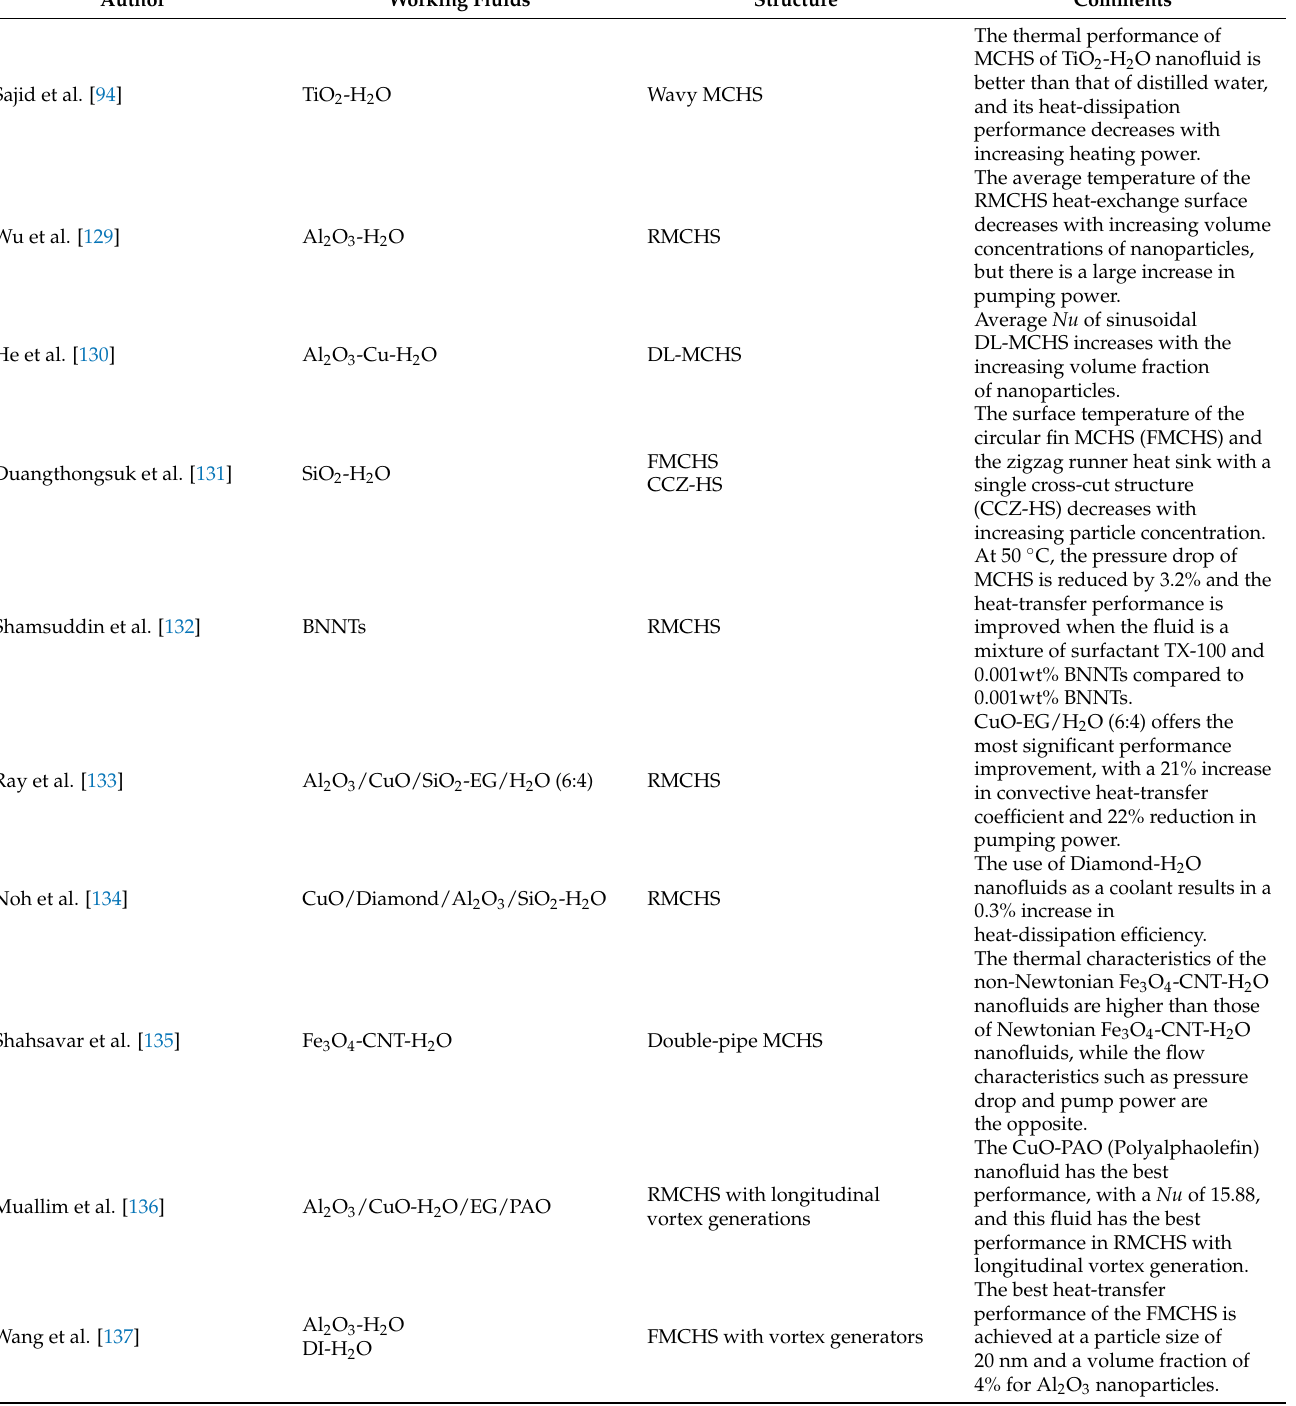
Table 7. Flow and heat-transfer performance of different MCHS structures using